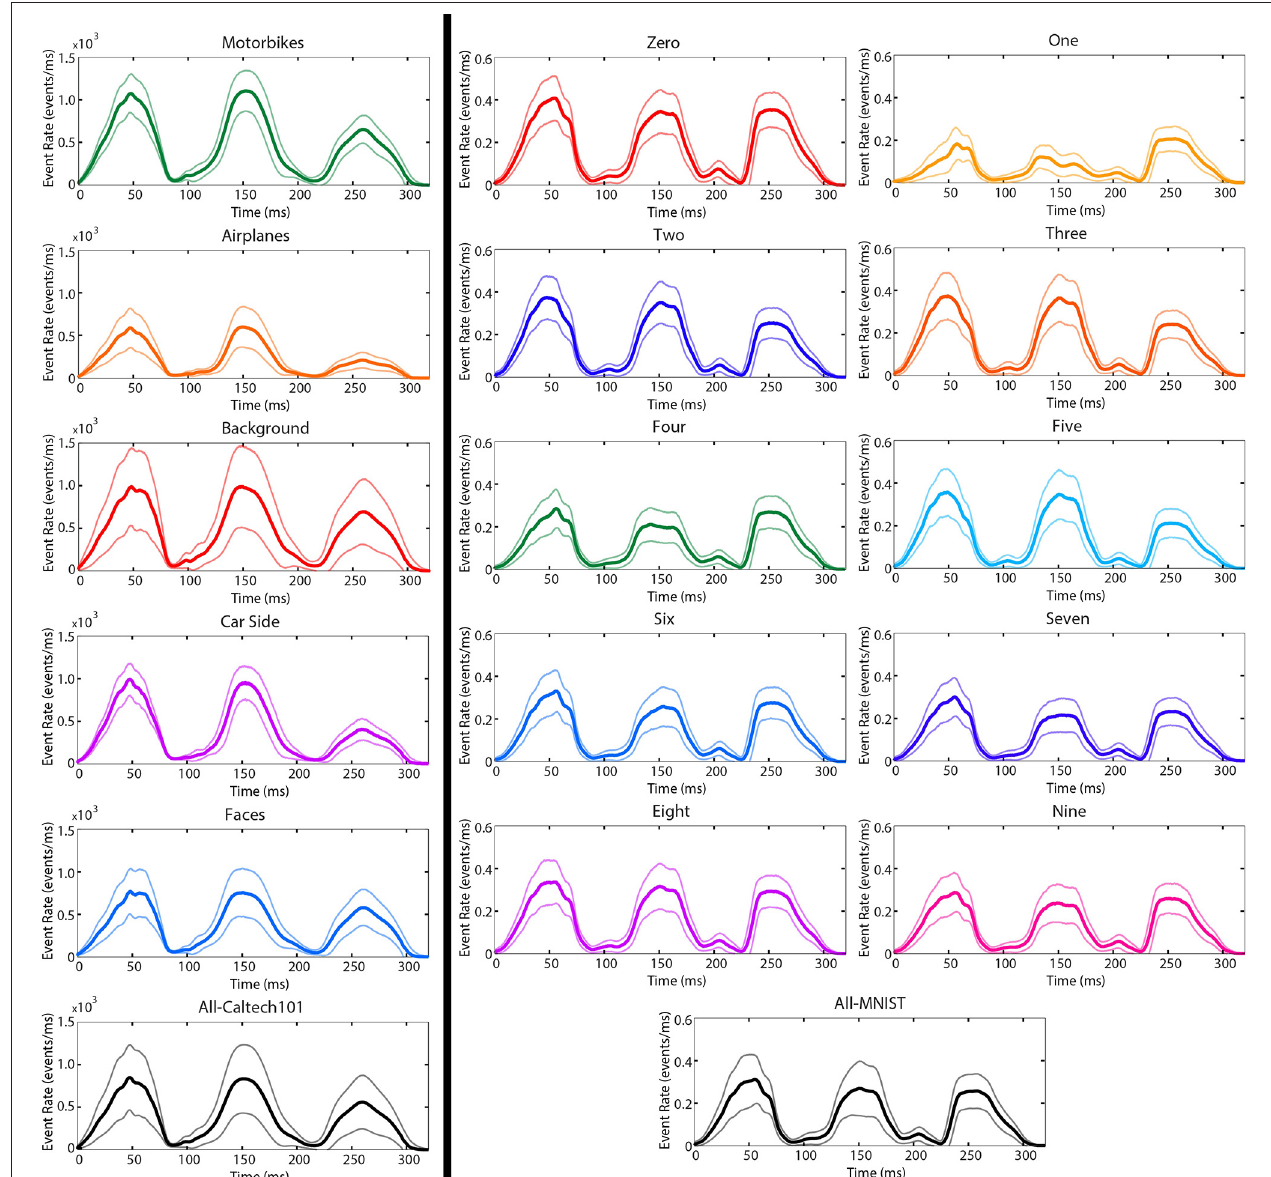
FIGURE 6 | The mean (solid) and standard deviation (transparent) event rates per µ s for popular N-Caltech101 categories (left) and the N-MNIST dataset (right). The three peaks in each plot correspond to the three saccades. As expected from Equation (2) , the maximum event rates occur near the middle of each saccade when the rotational velocity is